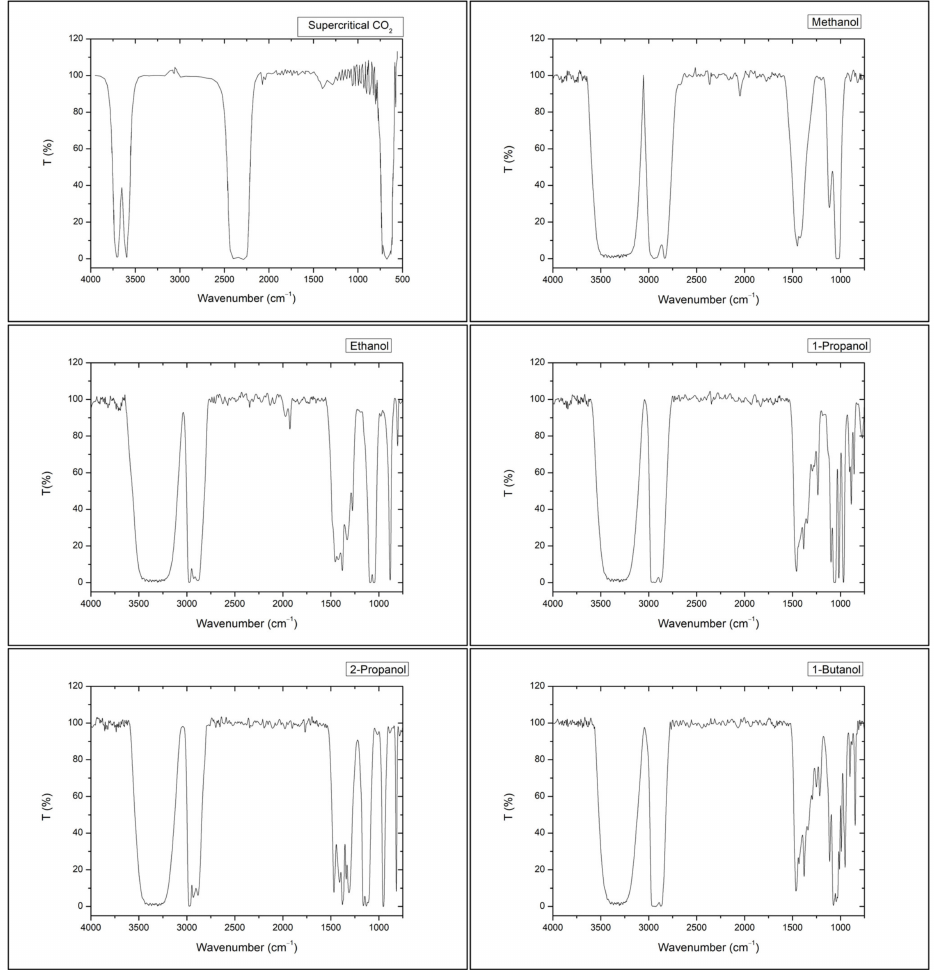
Figure 5. Transmittance infrared spectra of pure solutes. IR spectra for methanol, ethanol, 1-propanol, 2-propanol, and 1-butanol were obtained at 298.15 K and 0.1 MPa. IR spectra for supercritical CO 2 was obtained at 306.15 K and 10.5